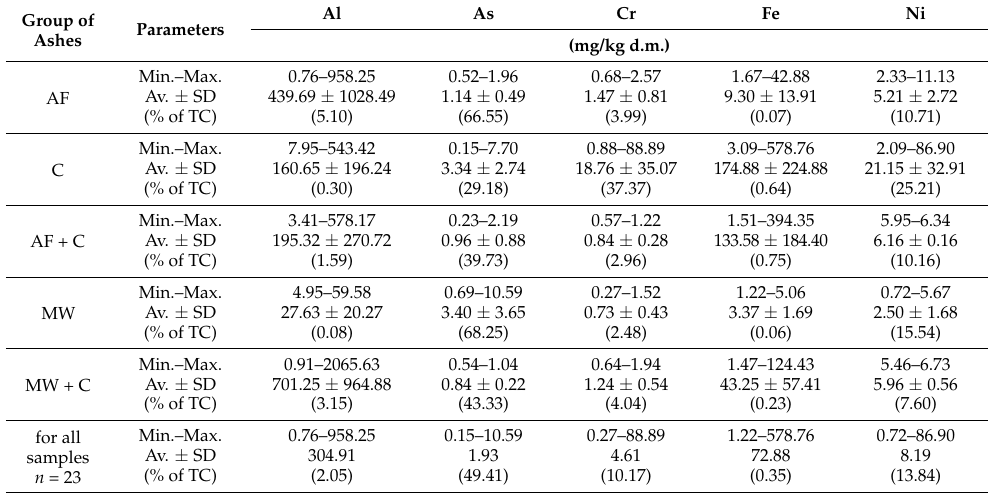
Table 3. Content of ion- and carbonate-exchange fractions of PTEs in household ashes.